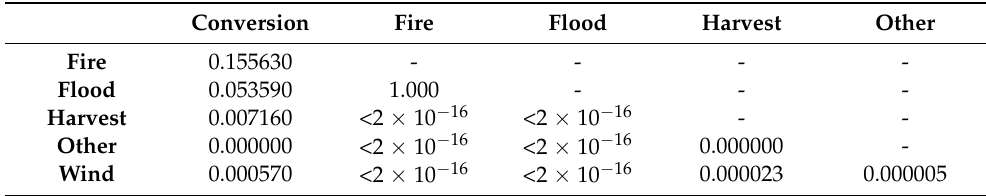
Table 5. p -values for pairwise comparisons of standing above ground biomass among disturbance agent combinations ( α = 0.05).